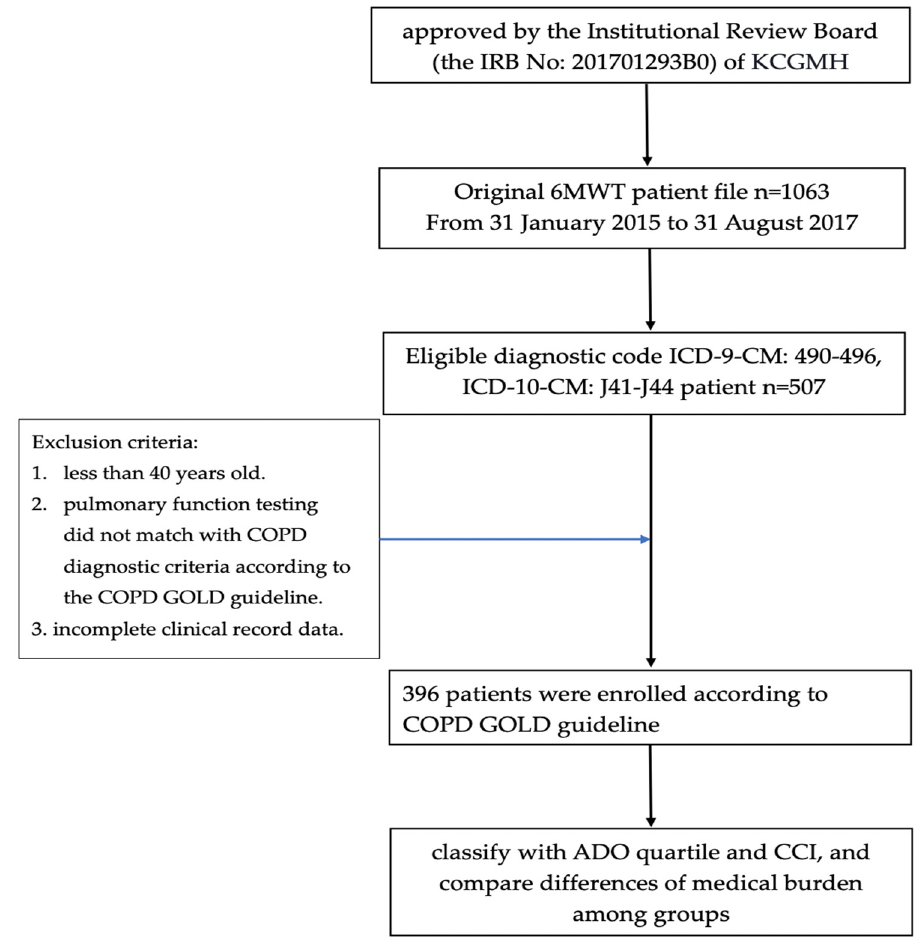
Figure 1. Flow chart of selected participants in this study.